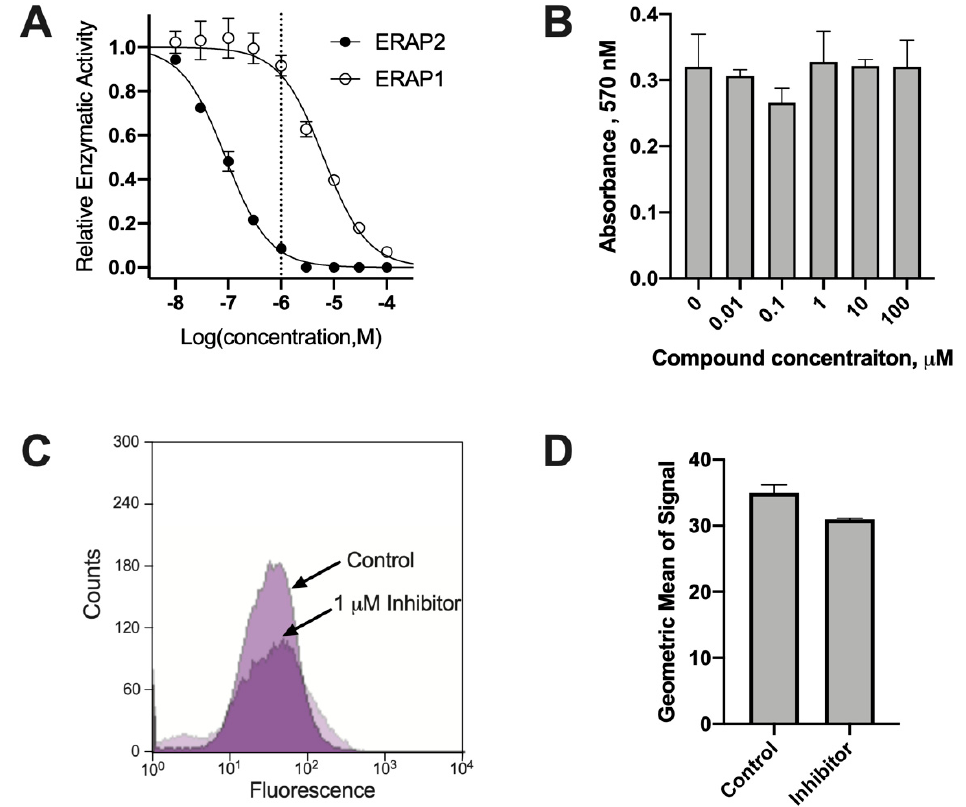
Figure 1. Activity of the phosphinic inhibitor DG011A. Panel ( A ), titration of DG011A inhibits ERAP2 with a 70-fold higher potency than ERAP1. Panel ( B ), DG011A shows no toxicity versus MOLT-4 cells up to 100 µ M as measured by the MTT assay. Panel ( C ), representative FACS traces used for the quantitation of the presence of HLA molecules (stained by the W6/32 antibody) on the surface of MOLT-4 cells incubated with 1 µ M DG011A. Panel ( D ), quantitation of the geometric mean of the signal from the FACS experiments.